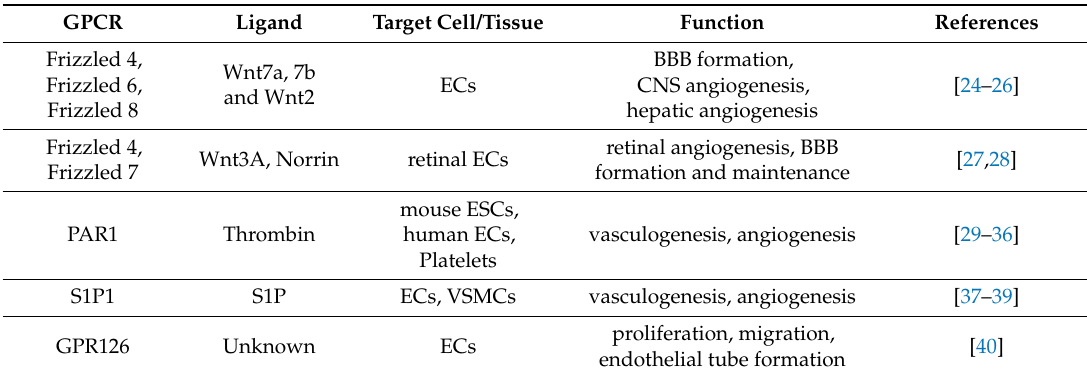
Table 1. GPCRs involved in the regulation of vasculogenesis and angiogenesis in physiological